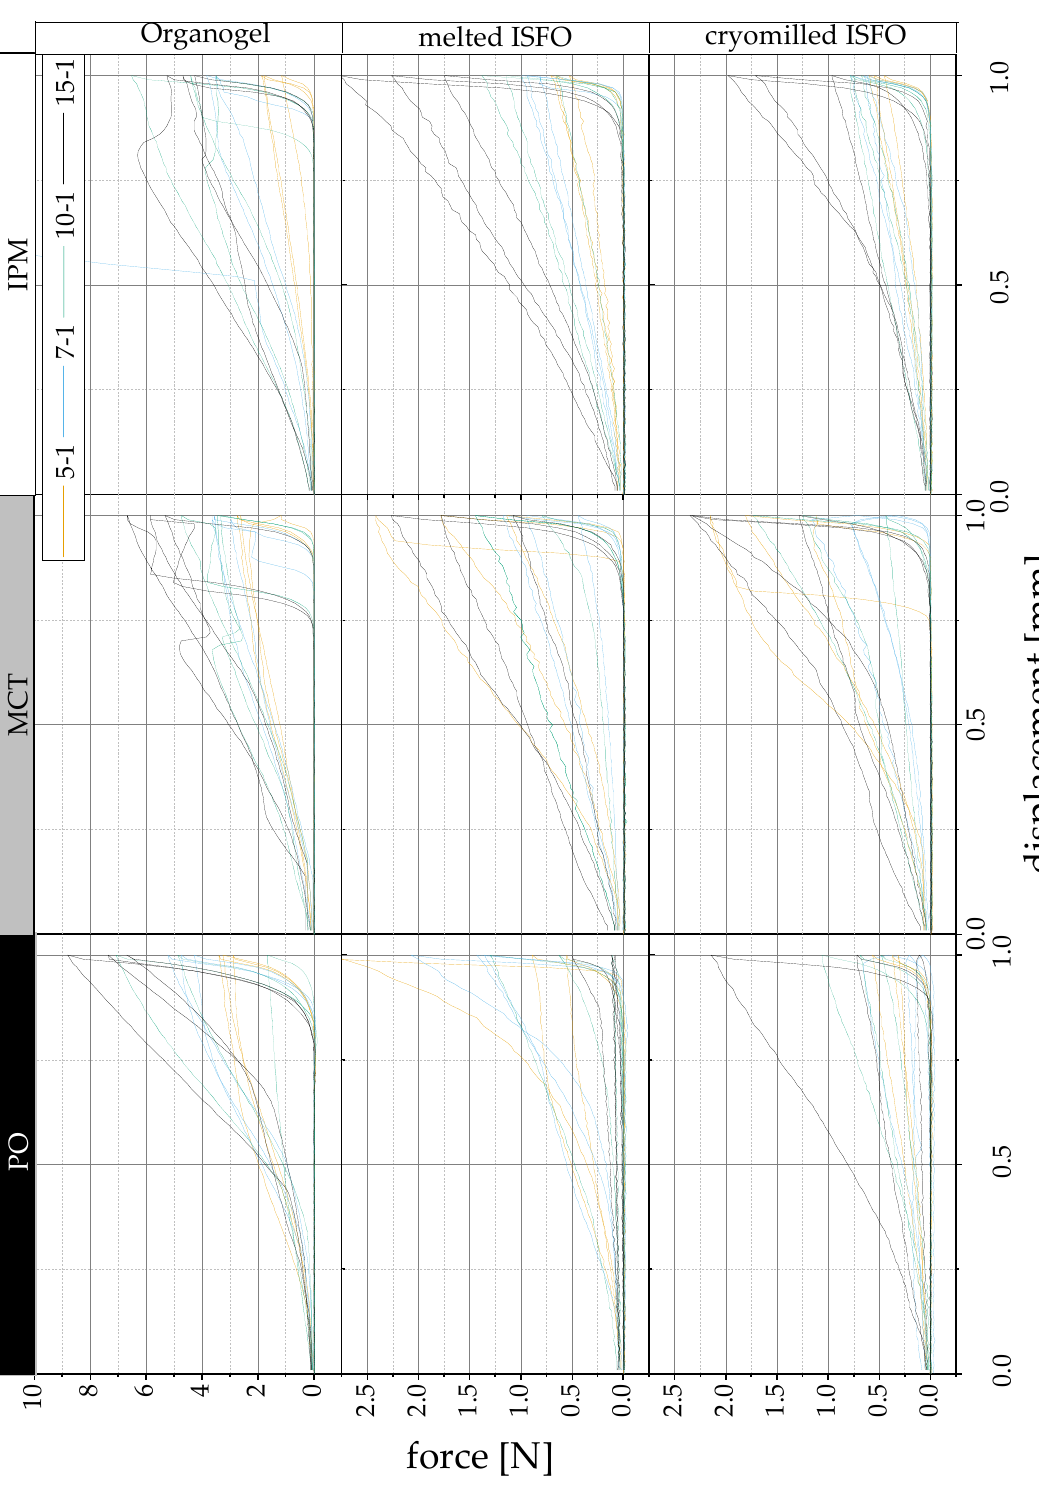
Figure A3. A comparison of all force–distance curves acquired via the texture analysis of the gel wafers. All force–distance curves are categorized based on their manufacturing methods in the columns and their lipid components in the rows. All triplicate measurements are shown in the same color.